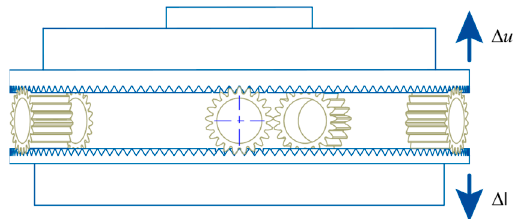
Figure 15. Diagram of the mounting error of a face gear.